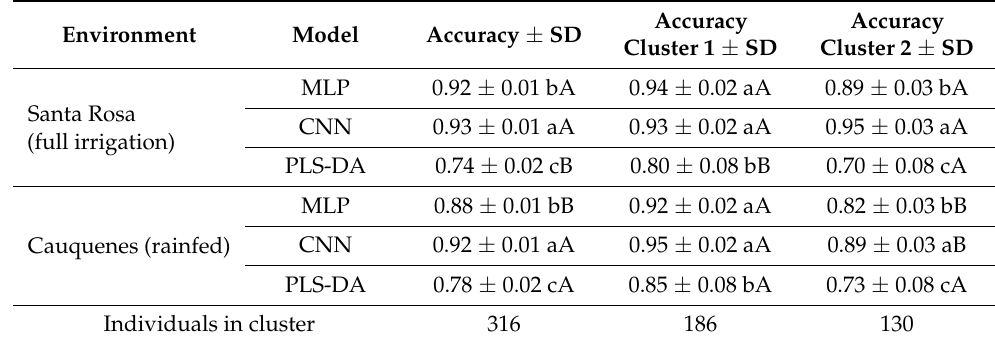
Table 3. Summary of the results of the classification accuracy on the test dataset for 10 repetitions in the wheat population in two